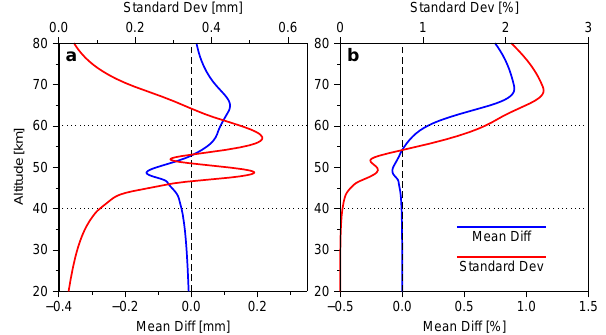
Figure 2. The errors of RA48 in the mean (blue curves) and stan- dard deviation (red): (a) absolute error (mm) and (b) relative error (%). Here, RA48 stands for a suppositional RA whose top is as- sumed to be 48km. The error of RA48 is defined as its difference in the excess phase from the original RA, the top of which is about